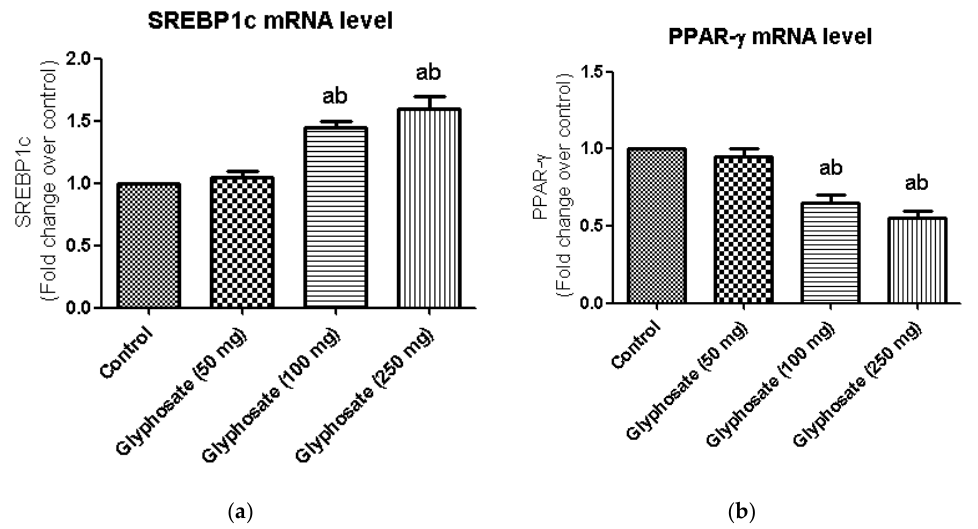
Figure 6. ( a , b ): Impact of glyphosate on mRNA levels of transcriptional factors like SREBP1c and PPAR- γ in control and glyphosate treated rats. SREBP1c and PPAR- γ mRNA expression were analyzed by Real Time-PCR using gene specific primers and results were expression in fold-change over control. Data were expressed as mean ± SEM where n = 6 rats for each group. Values significant at p < 0.05 were analyzed with a—control, b—glyphosate (50 mg/kg